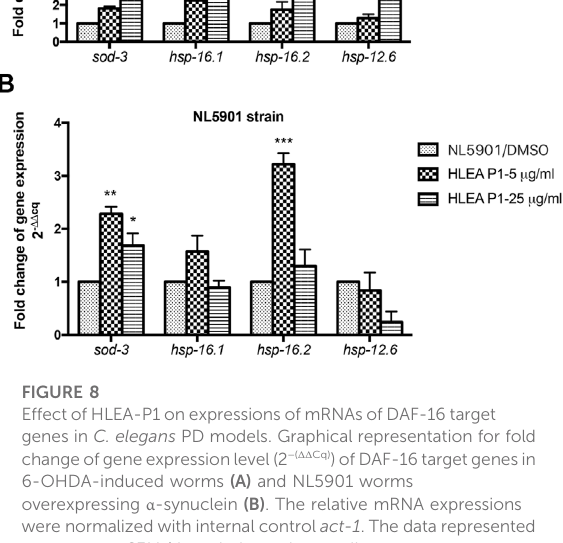
C 10 H 20 O 2 (Figure 9A and Supplementary Figures S2, S3). As shown in Figure 9B, Peak A at 0.85 ppm indicates a presence of terminal methyl group (CH 3 ) bounded to the C 9 . Peak B at 1.24 ppm displayed a long chain of methylene protons (CH 2 ) of the C 4 -C 9